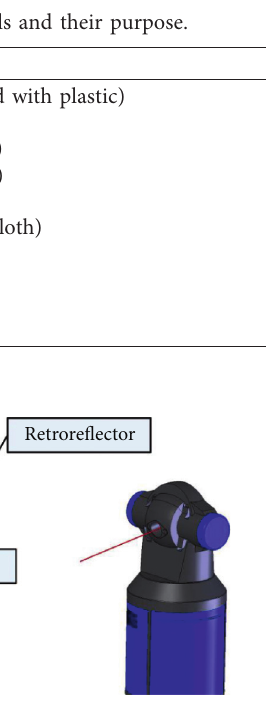
Figure 1: Laser tracker system [6].